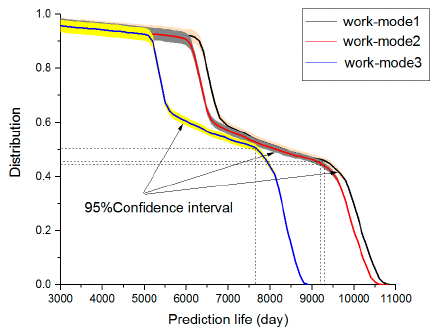
Figure 23. Life distribution of the FS with Configuration 3 in different work modes.